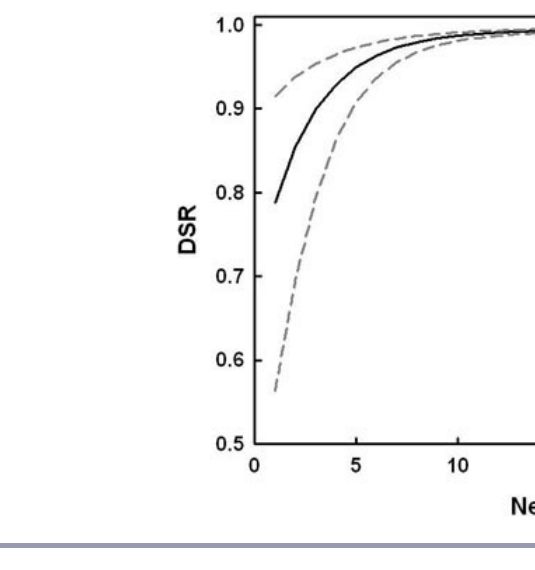
Fig. 2. Daily survival rate (DSR), and 95% confidence interval, as a function of nest age, averaged across all year by treatment combinations for nests on date 165 and median water depth of 31, for American Coot ( Fulica Americana ) nests at Grays Lake, Idaho during